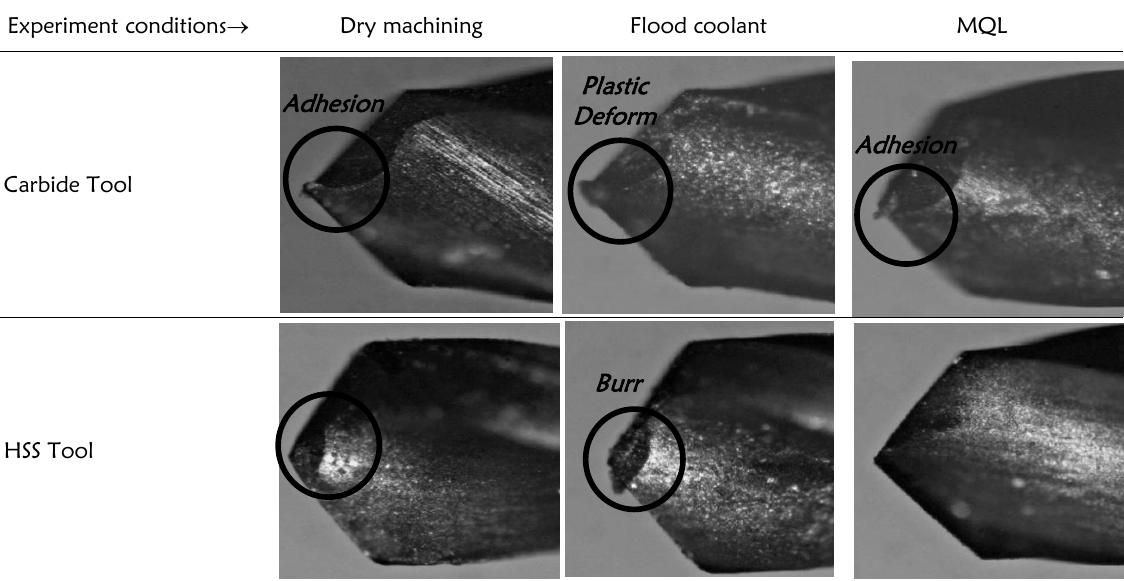
Table 3: Crater wear for Carbide and HSS tools